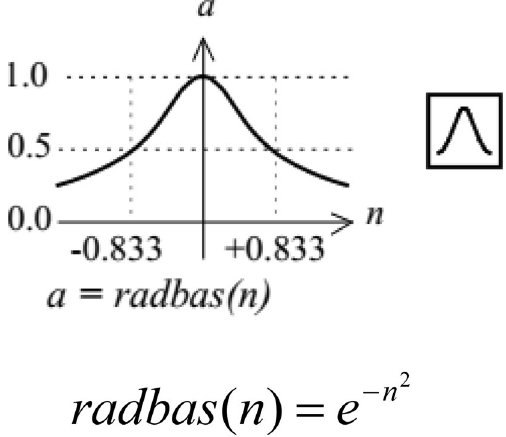
Fig. 2 Plot of the radial basis transfer function (Demuth and Beale